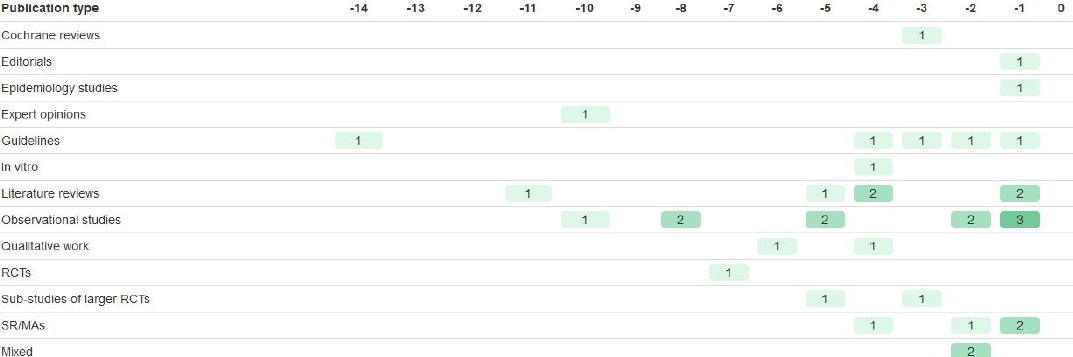
Figure 5. Evidence cited by the GGST statin trial to justify inclusion of the SLCO1B1 biomarker, relative to the publication of the 2016 rationale and design paper [44]. ‘Mixed’ refers to papers that used a mixture of two or more of the other publication types. RCT = randomised controlled trial SR/MAs = systematic reviews/meta-analyses.